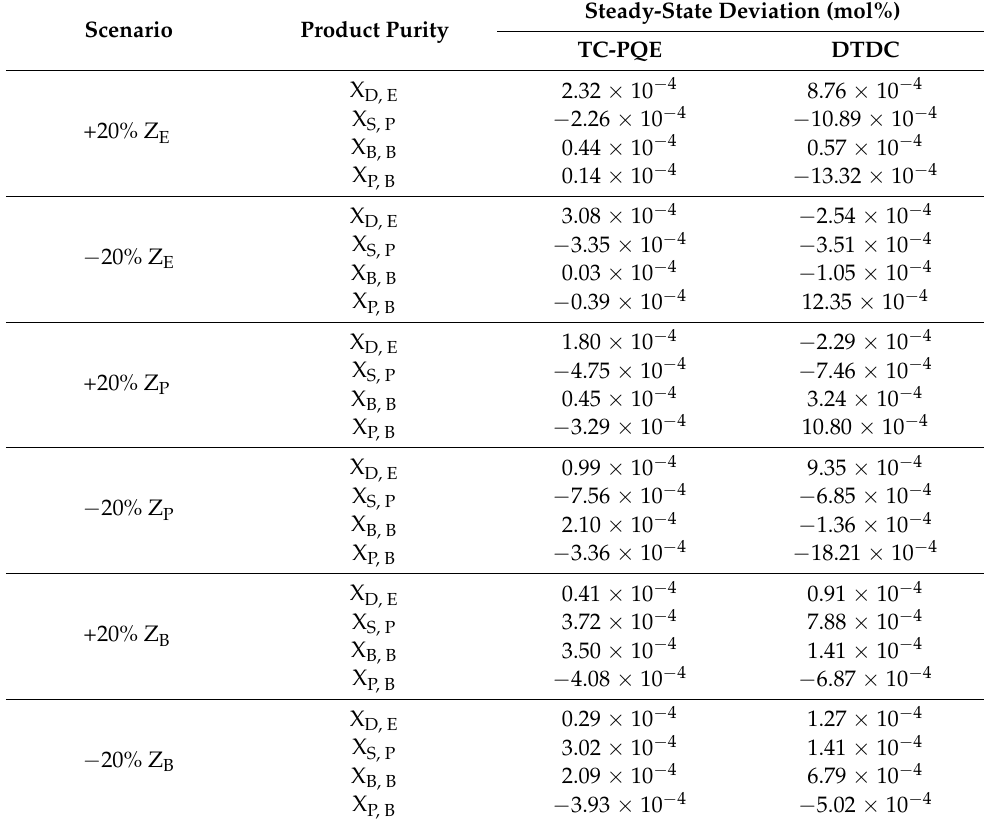
Table 4. Steady-state deviations for ± 20% variations in feed compositions of E, P, and B (Example I).